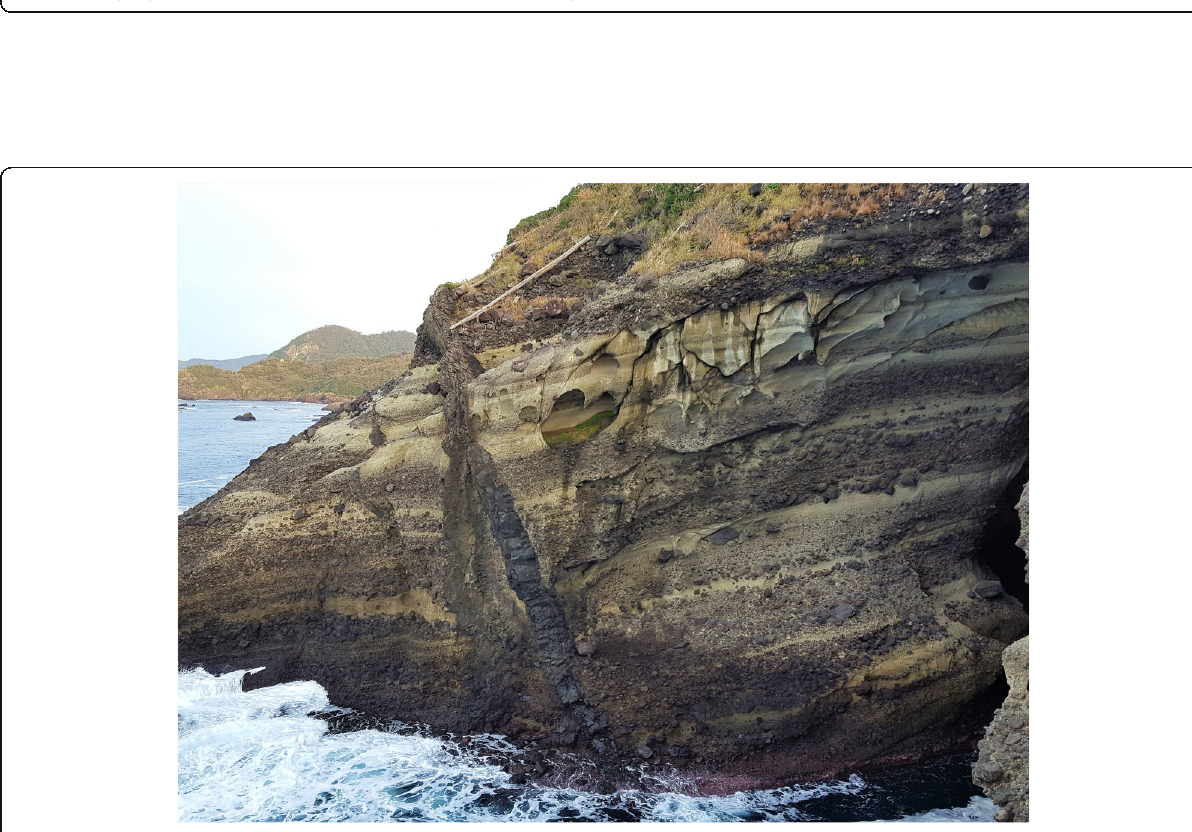
Fig. 9 Deposits from a pyroclastic density current of the lower Miocene Koura formation. Notice abundant armored lapilli in the basal part of the section, a vaguely stratified pumice rich central part and several fining upward subsets in the topmost part (pencil-tip)